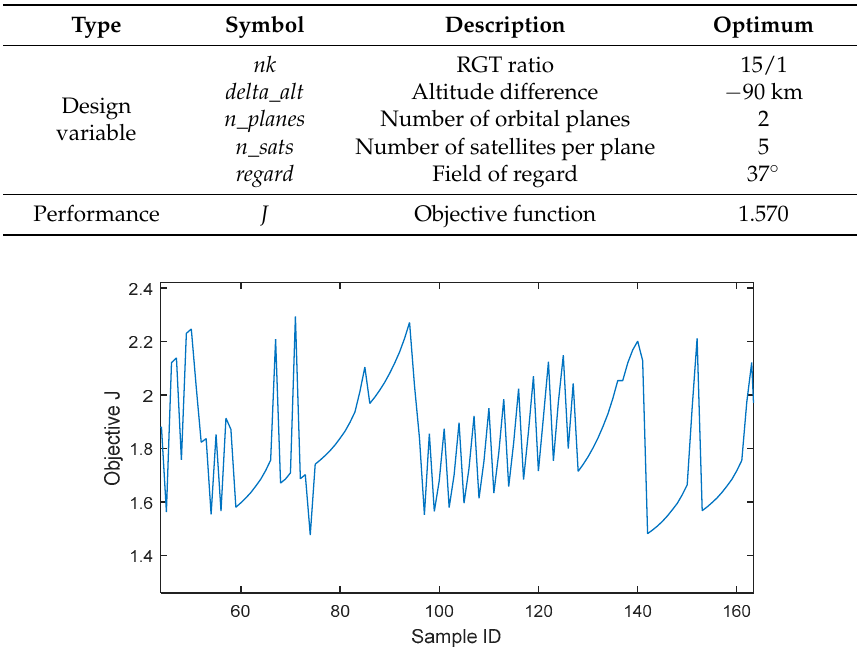
Figure 16. Time taken by each method and solution optimality. Direct comparison with static satellite constellations is not straightforward because they cannot adopt the “choice and concentration” observation strategy of a ReCon; a static constellation cannot lock its satellite orbits after a ground event occurs, and the orbits will keep CPU time (sec)